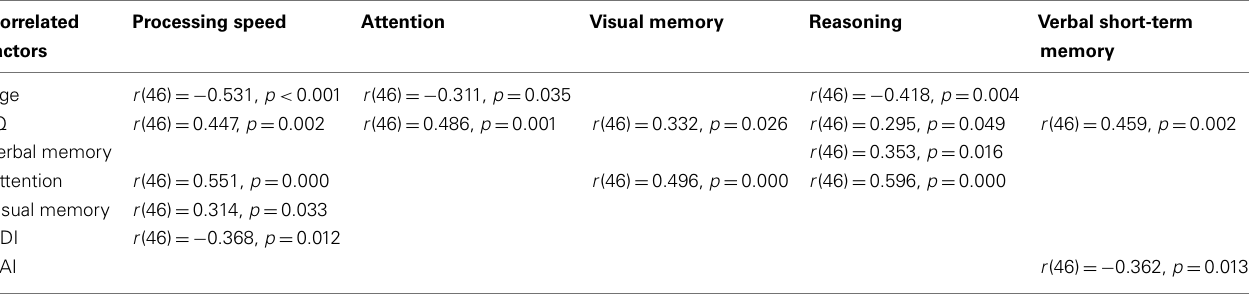
Table 2 | Demographic and neuropsychological data correlation for all study